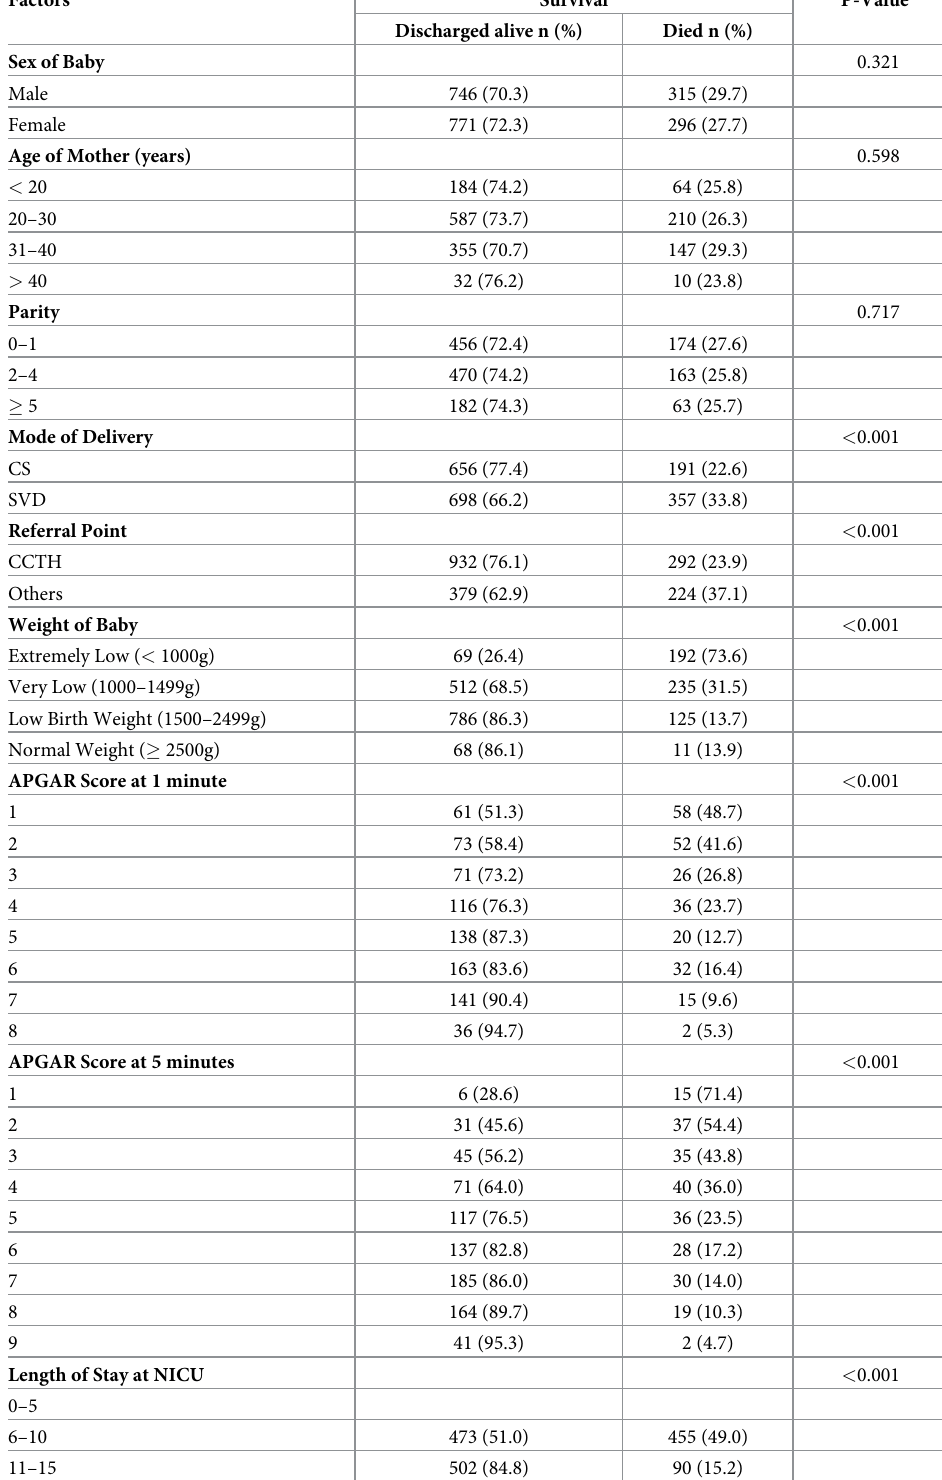
Table 2. Factors influencing the survival outcomes of preterm